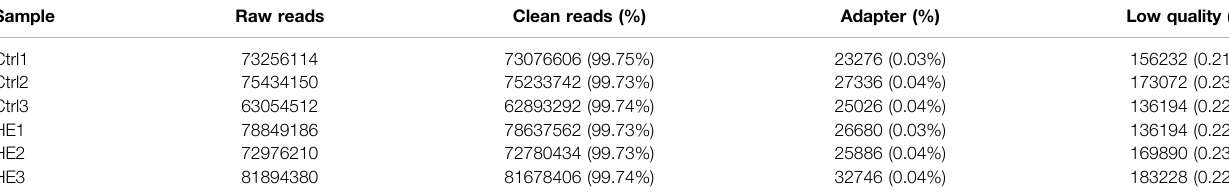
TABLE 1 | Summary of draft reads of six libraries by RNA-sequencing.